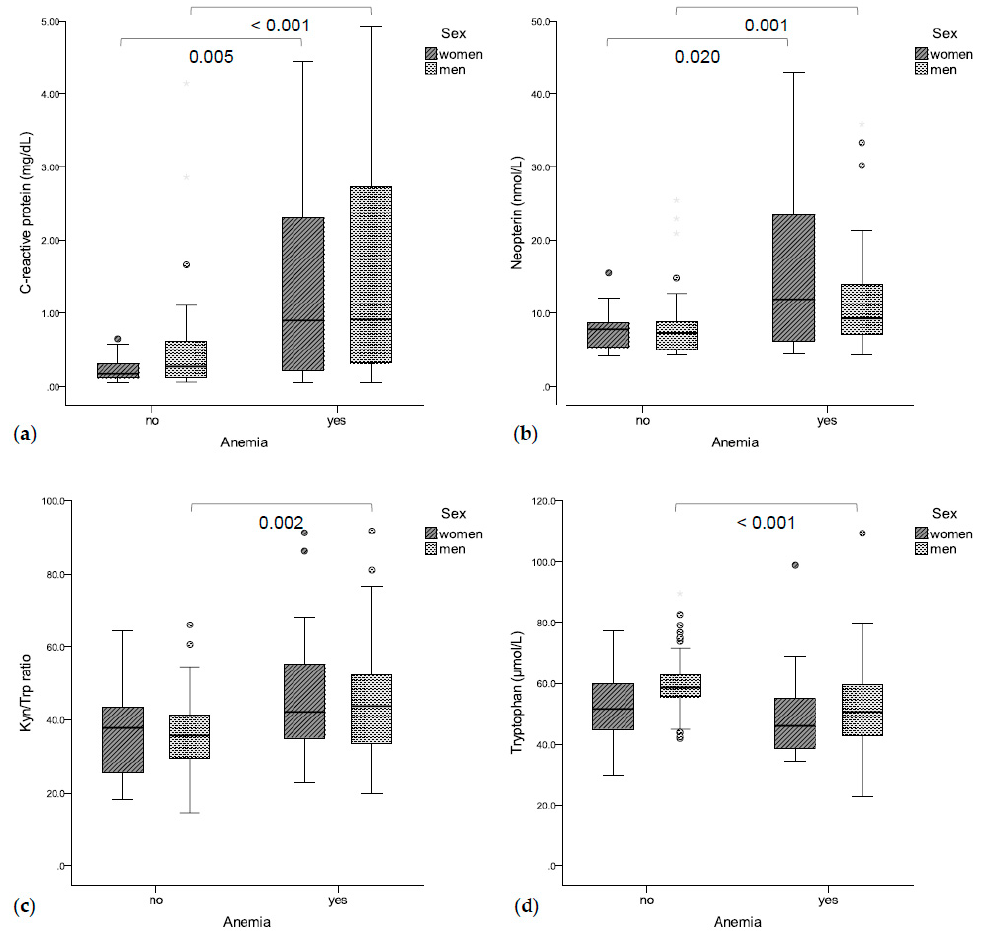
Figure 1. ( a ) Anemic patients had significantly higher C-reactive protein ( b ) and neopterin concentrations. ( c )AnemicmenalsohadahigherKyn / Trpratio( d